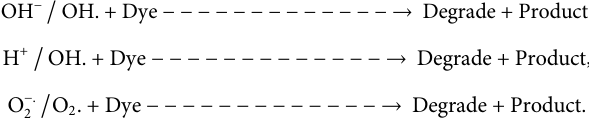
Photocatalytic degradation of dyes: The principal photoreactions show that (e – + h + ) pairs play a crucial role in photocatalytic dye degradation. OH − , O 2 , and HO 2 . radicals and photogenerated holes (h+) are highly reactive intermediates that react continuously on the neighboring species, eventually resulting in total degradation of the dye compounds and the oxidative, reductive role of the species, i.e., OH, h + , and e - in the dye degradation process as shown in Schemes 1, 2.